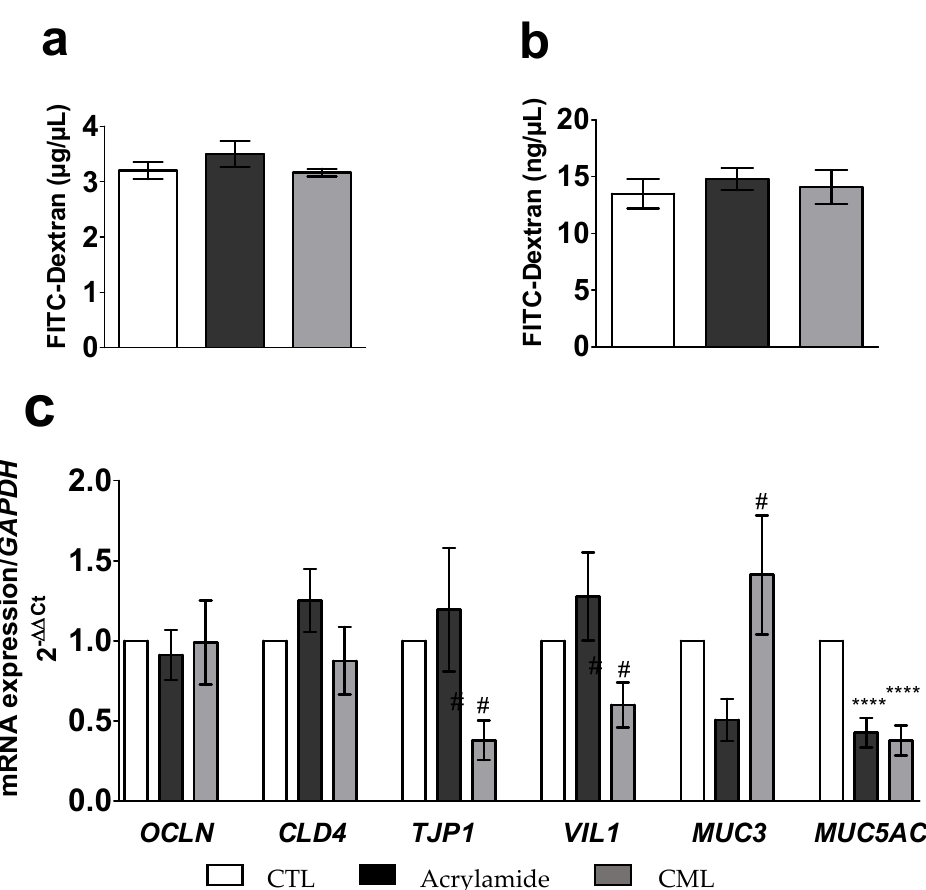
Figure 5. Effect of a 6 h incubation with CML (300 μM) or acrylamide (5 mM) on the levels of FITC-Dextran in the apical ( a ) and the basal ( b ) media, and the mRNA expression of genes coding for tight junctions and mucins ( c ) from the Caco-2/TC7 and HT29-MTX co-culture. Data are expressed as the mean ± SEM ( n = 12). The level of gene expression was expressed as the fold induction over the CTL group set at 1. **** statistically significant difference ( p < 0.001 vs. CTL), # statistically significant difference ( p < 0.05 vs. acrylamide). CML, N ε -Carboxymethyllysine; CTL, control; CLDN4 , Claudin 4; MUC3